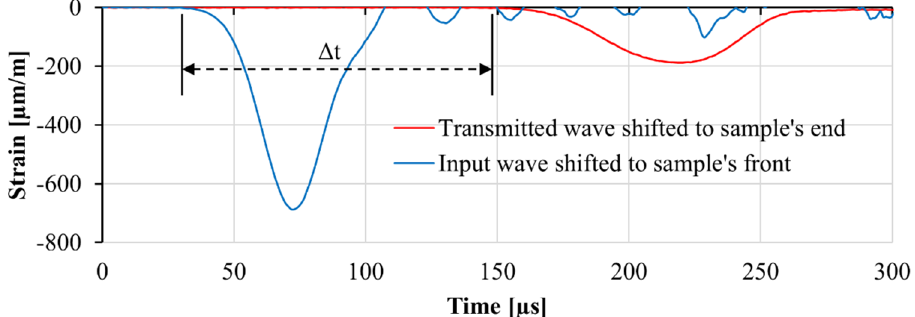
Figure 11. An example of the input wave and transmitted wave shifted respectively to the front and backside of the long specimen. Δt denotes the time needed for the wave to travel through the specimen.